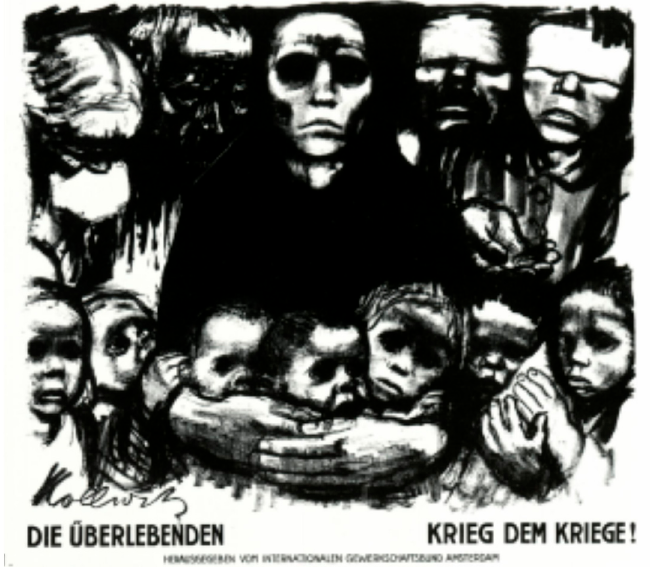
Figure 6. Käthe Kollwitz, The Survivors , 1923. German version of the poster. Based on the lithograph of the same name on beige wove paper, 1923. 56.2 cm × 68.5 cm. See (von dem Knesebeck 2002, pp. 582–85).